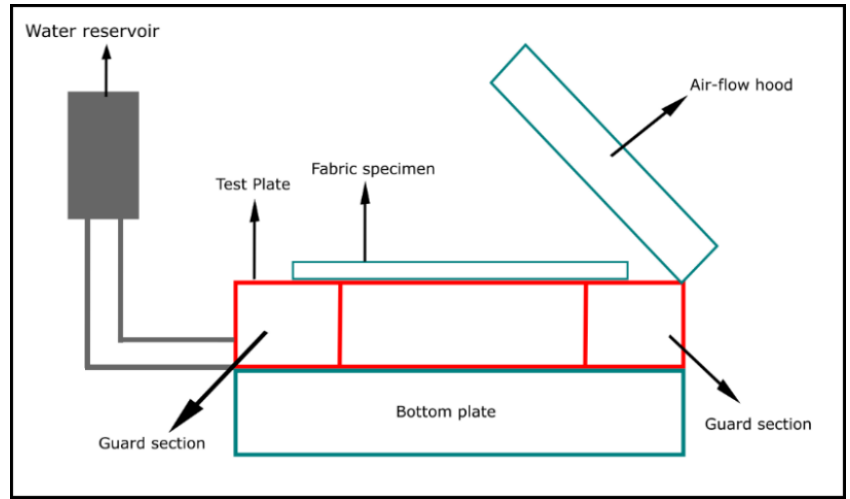
Figure 7. Thermo-physiological comfort performance evaluating tester — Sweating Guarded Hot